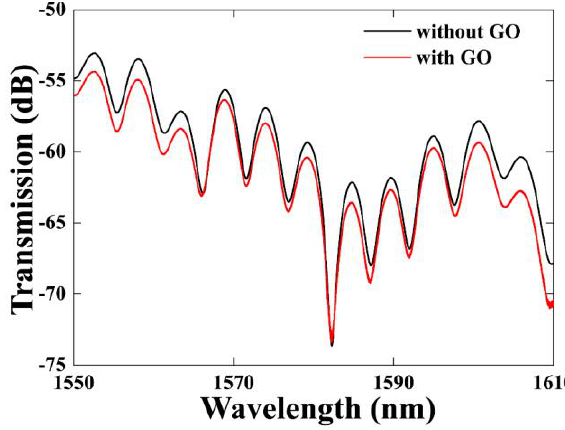
Figure 5. SEM image of the tapered-TCF after coating with GO. Resolution: ( a ) 50 μ m, ( b ) 5 μ m.